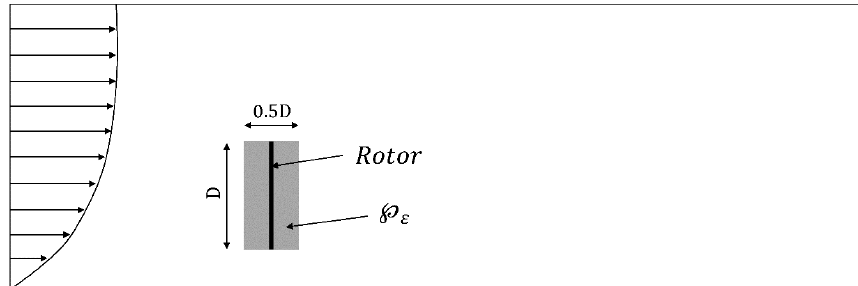
Figure 1. Extended k ‐ε model.